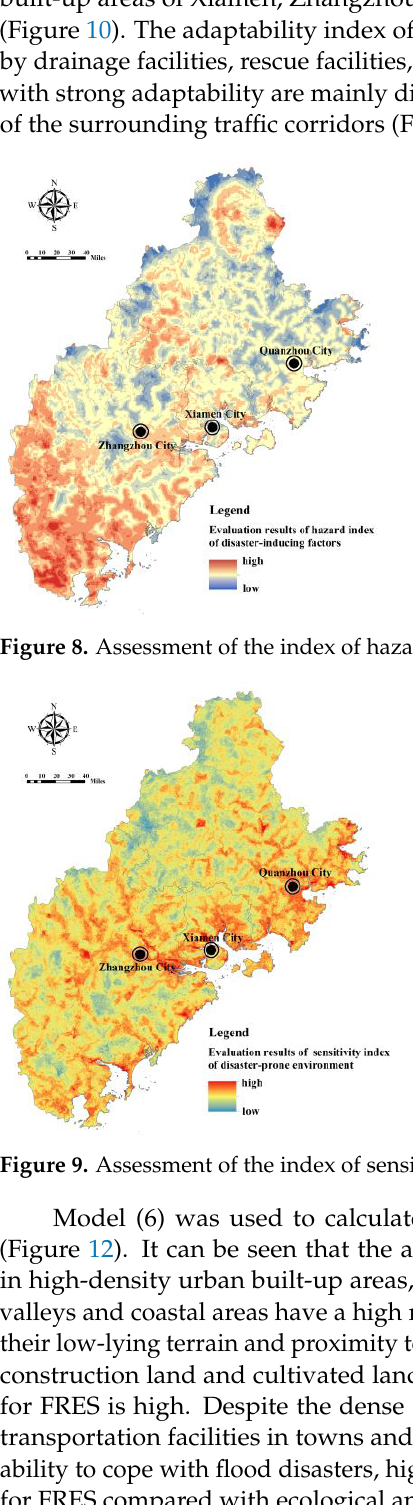
Figure 10. Assessment of the index of exposure of disaster-bearing bodies in Fujian Delta.